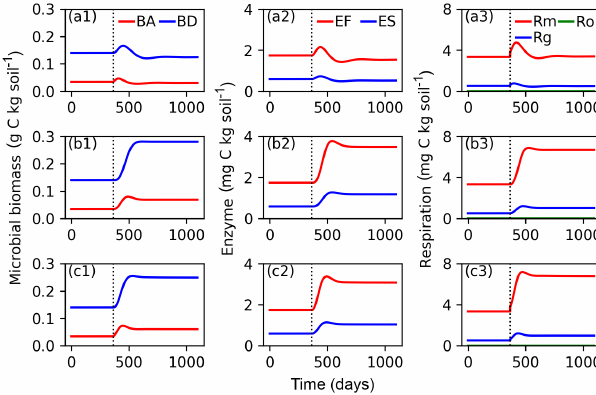
Figure 6. Evolutions of active (BA) and dormant (BD) microbial biomass; FOM decomposing enzymes (EF) and SOM decompos- ing enzymes (ES); and maintenance respiration (Rm), growth respi- ration (Rg) and overflow respiration (Ro) for CN-MFT3 (standard version of ORCHIMIC) when temperature is stepwise increased by 5K (a1, a2, a3) , when FOM input doubles (b1, b2, b3) and when both forcings are changed (c1, c2, c3) . The vertical black dotted line shows the time when the stepwise increase of temperature and/or the doubling FOM input was